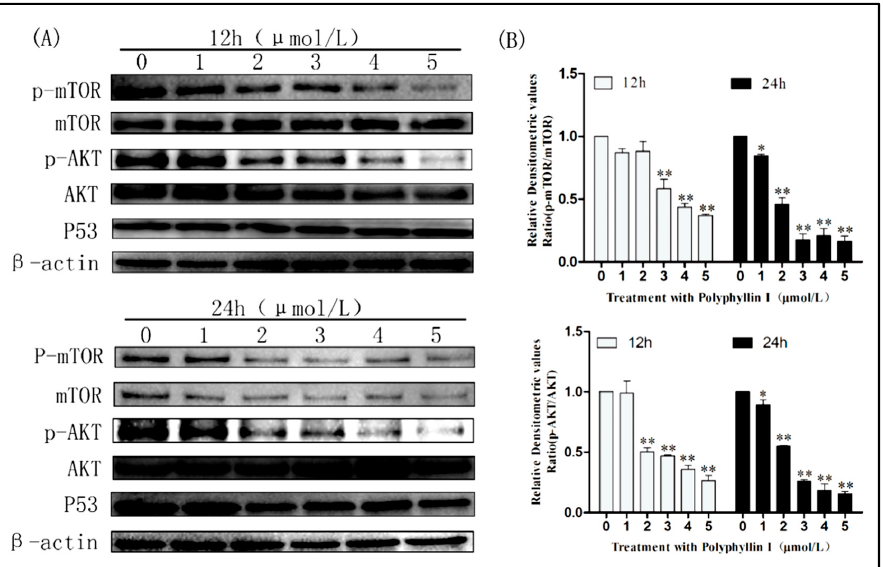
Figure 6. PPI induced autophagy via AKT/mTOR pathway in SW480 cells. ( A ) AKT/mTOR path